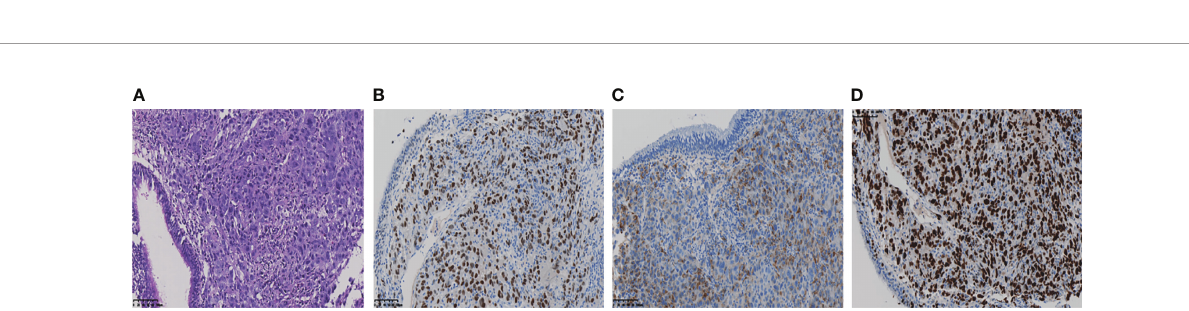
FIGURE 1 | CT scan and MRI images. (A) CT scan of lung lesions (left and middle panel) and MRI pro fi le (right panel) before Savolitinib treatment. (B) CT scan of lung lesions (left and middle panel) and MRI pro fi le (right panel) 2-months post Savolitinib treatment. The red arrow indicates the location of the lesion.